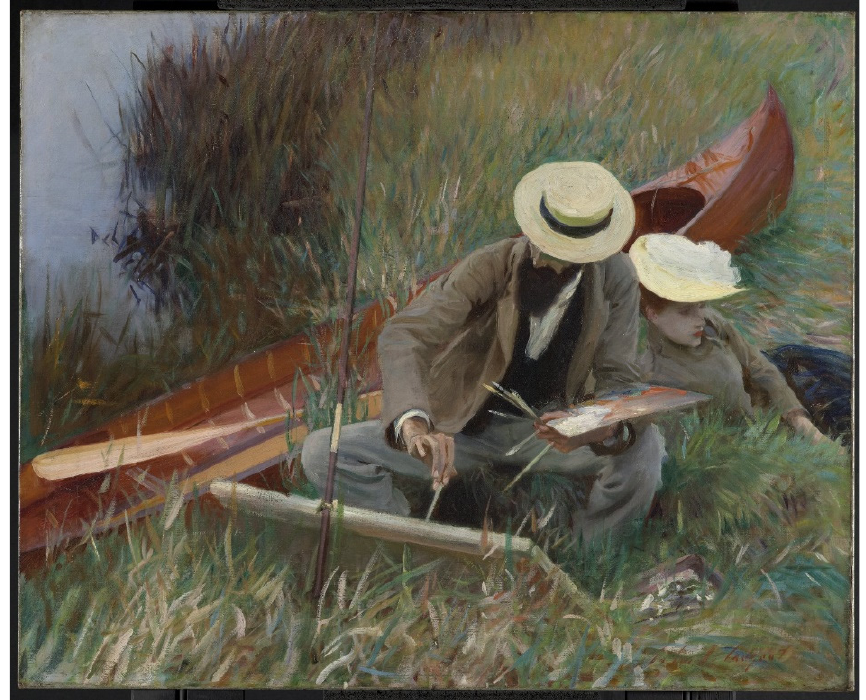
Figure 7. John Singer Sargent, An Out-of-Doors Study , 1889, oil on canvas, 66.4 × 81.6 cm, Brooklyn Museum of Art, Museum collection fund 20.640 (Photo: Brooklyn Museum,